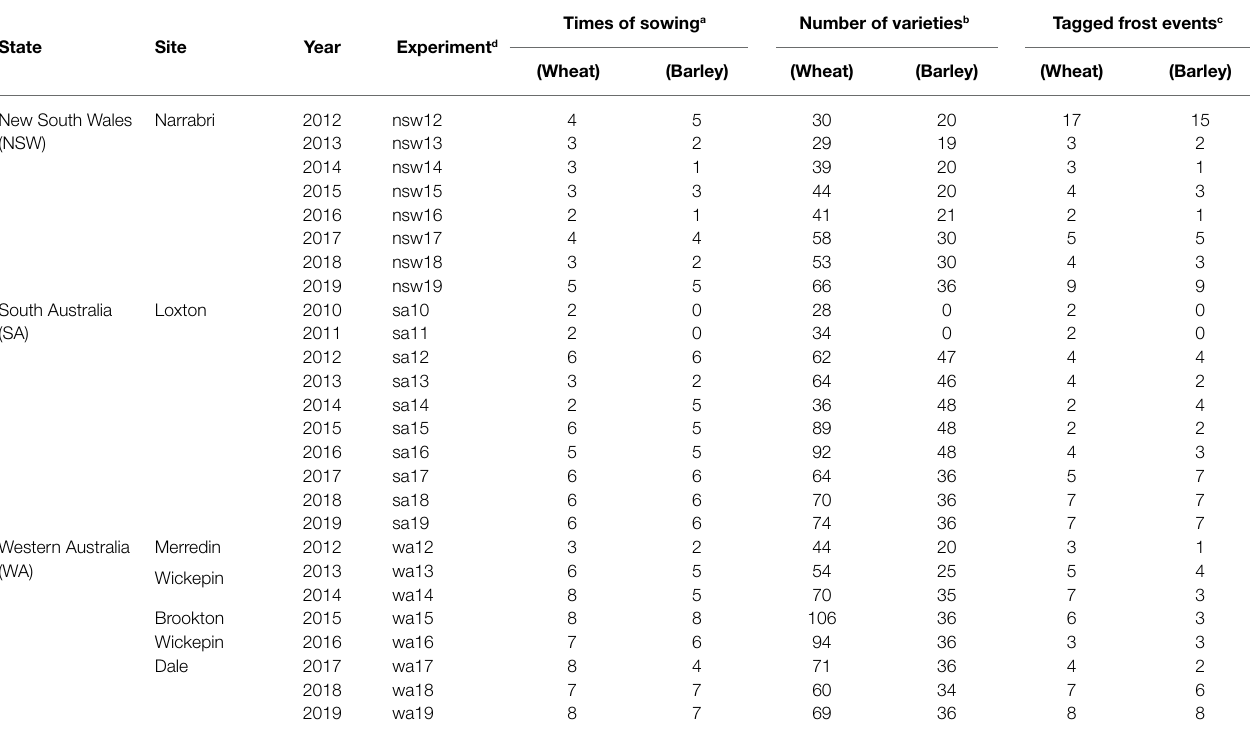
TABLE 1 | Experimental details described in the multi-environment trial (MET) data-set including different states, sites, experiments (26 and 24 in wheat and barley, respectively), times of sowing (TOS; resulting in a total of 126 and 108 different growing conditions in wheat and barley), number of varieties assessed and number of tagged frost